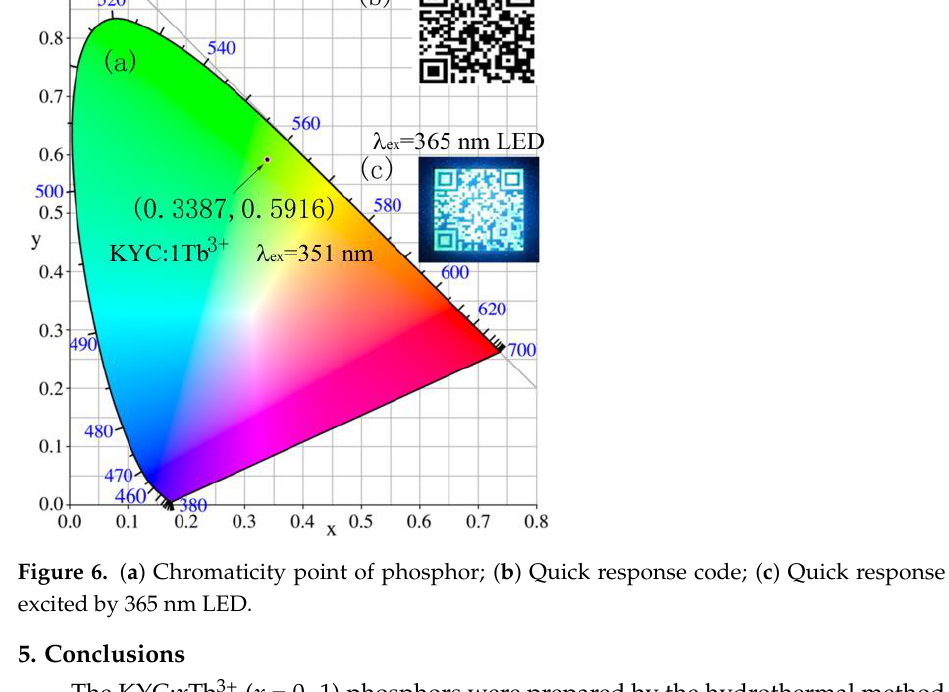
nm; Figure S2: Emission spectra of KYC: x Tb 3+ ( x = 0.001, 0.01, 0.1) excited at 351 nm.